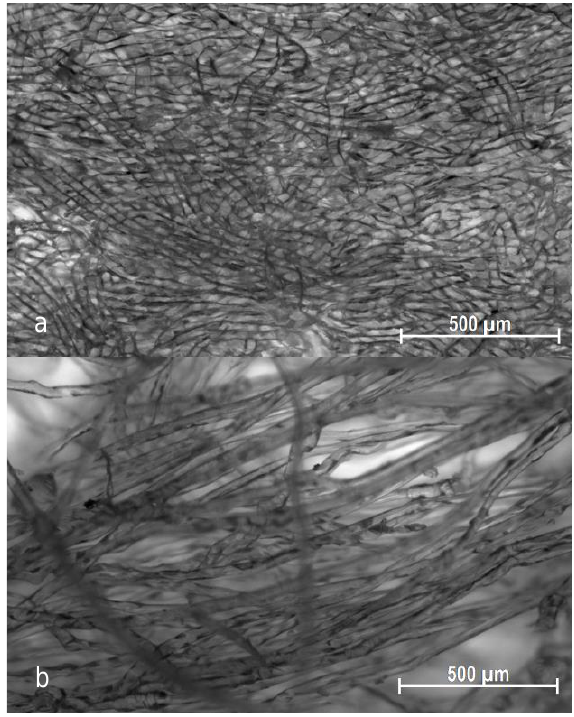
Figure 4. Optical microscope image of nonwoven. ( a ) upstream side ( b ) downstream side.